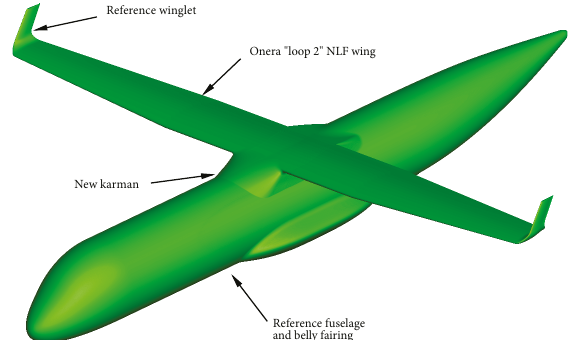
Figure 9: AG2-NLF con fi guration considered.